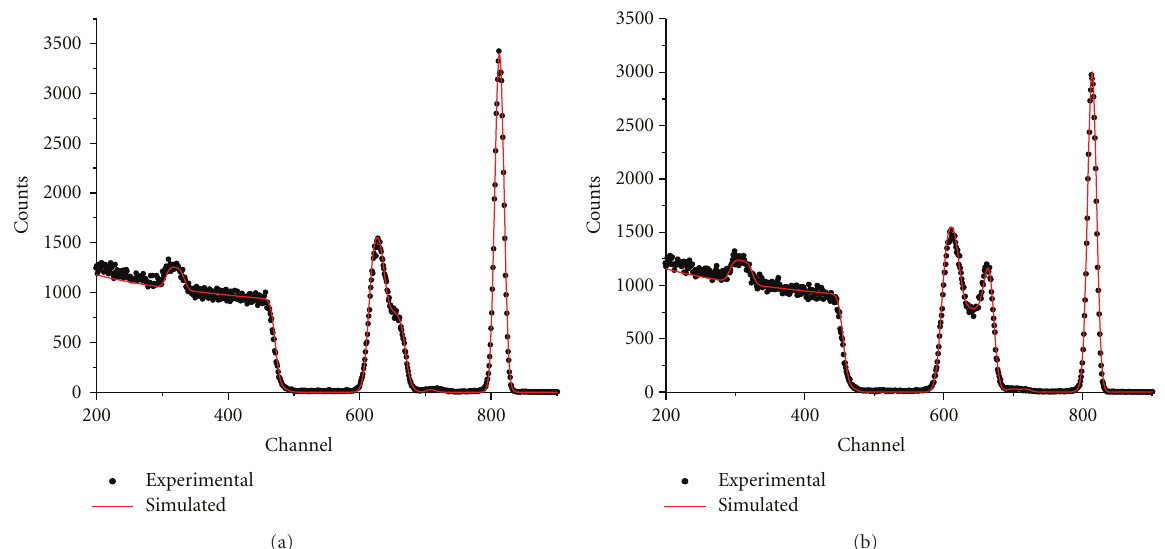
Figure 1: Measured (markers) and fitted (red line) RBS spectra for (a) Pd/TiO 2 /Ti and (b) Pd/Ti/TiO 2 /Ti films deposited on Si (111).